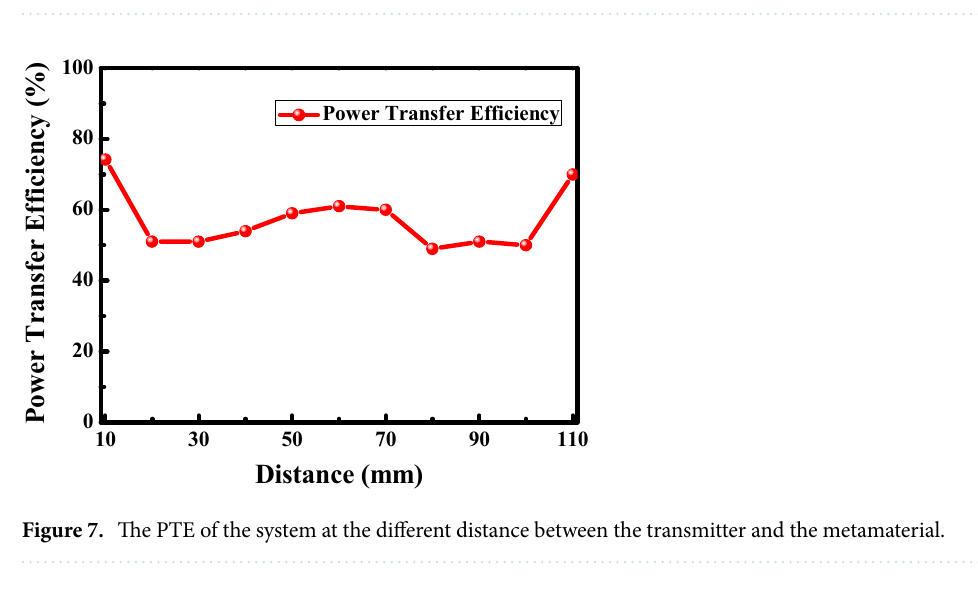
Figure 6. The effective permeability of the frequency reconfigurable metamaterial at different frequencies.